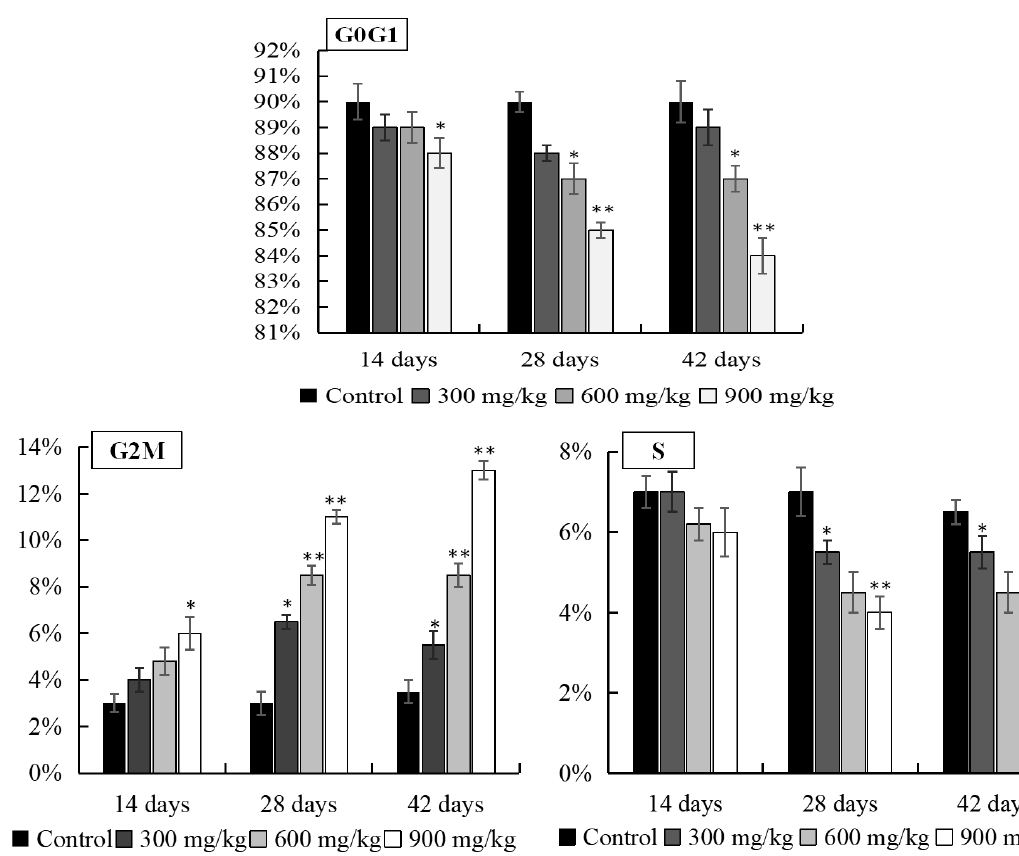
Figure 1. Changes of cell cycle phase distribution (%) in the cecal tonsil. Data are presented with the mean ± standard deviation (n=6) *P<0.05, compared with the control group **P<0.01, compared with the control